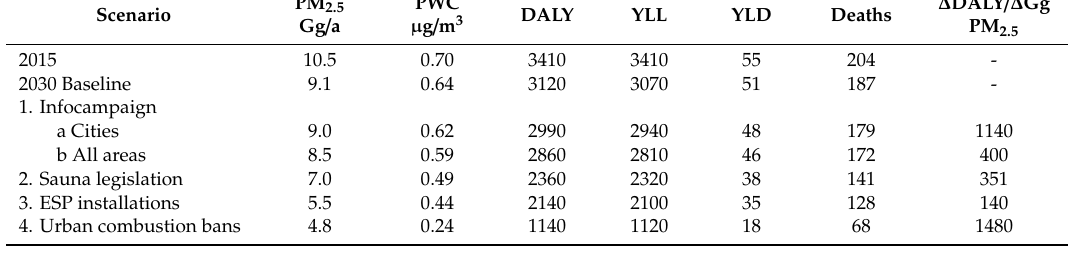
Table 3. Estimates for disease burden attributable to RWC in the studied scenarios. The scenarios have been evaluated with respect to Baseline in 2030. The scenarios are cumulative, i.e., they also include the measures defined in the previous scenarios. The notations: DALY = disability adjusted life years, YLL = years of life lost, YLD = years lived with disability, ∆ DALY / ∆ Gg PM 2.5 = changes compared to 2030 baseline.